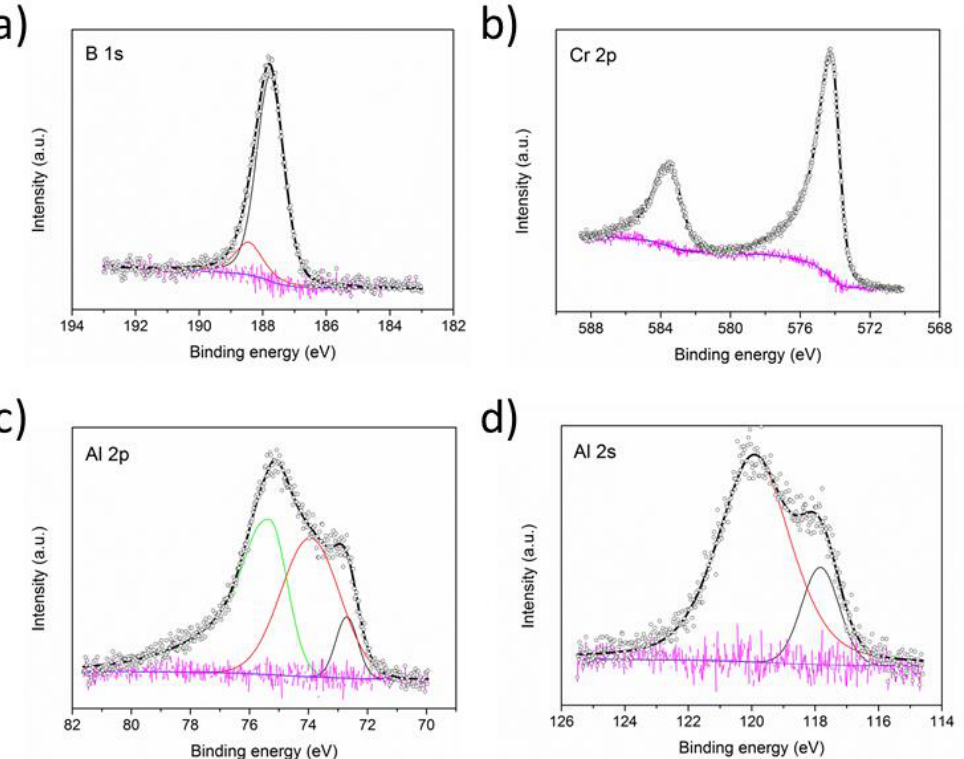
Figure 8. XPS B 1s ( a ), Cr 2p ( b ), Al 2p ( c ) and Al 2s ( d ) spectra collected for sample A. The circles mark the raw intensities and the blue line the Shirley background. The peaks in colour indicate the fitted contributions with their sum in black and the di ff erence to the raw data in pink. The green line in ( c ) represents the contribution of the overlapping Cr 3s peak.